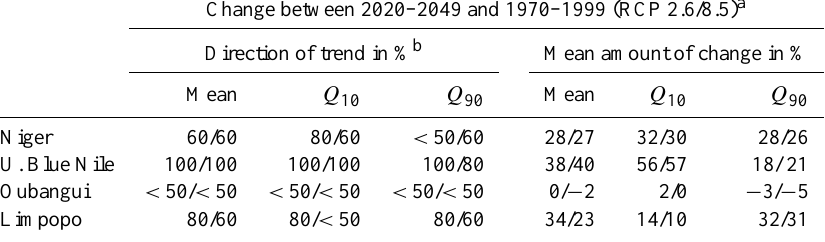
Table 4. Summary of modelling